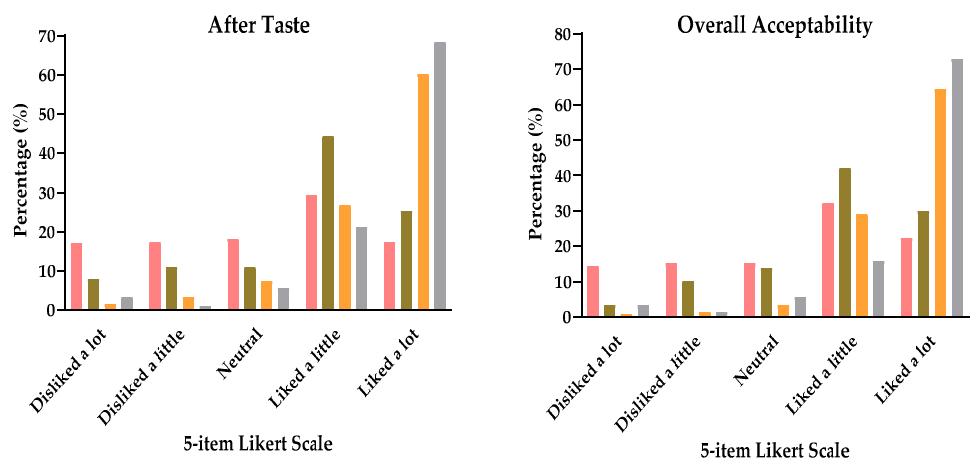
Figure 2. Maternal responses on sensory attributes of orange-fleshed sweet potato (OFSP) based complementary foods and Weanimix.